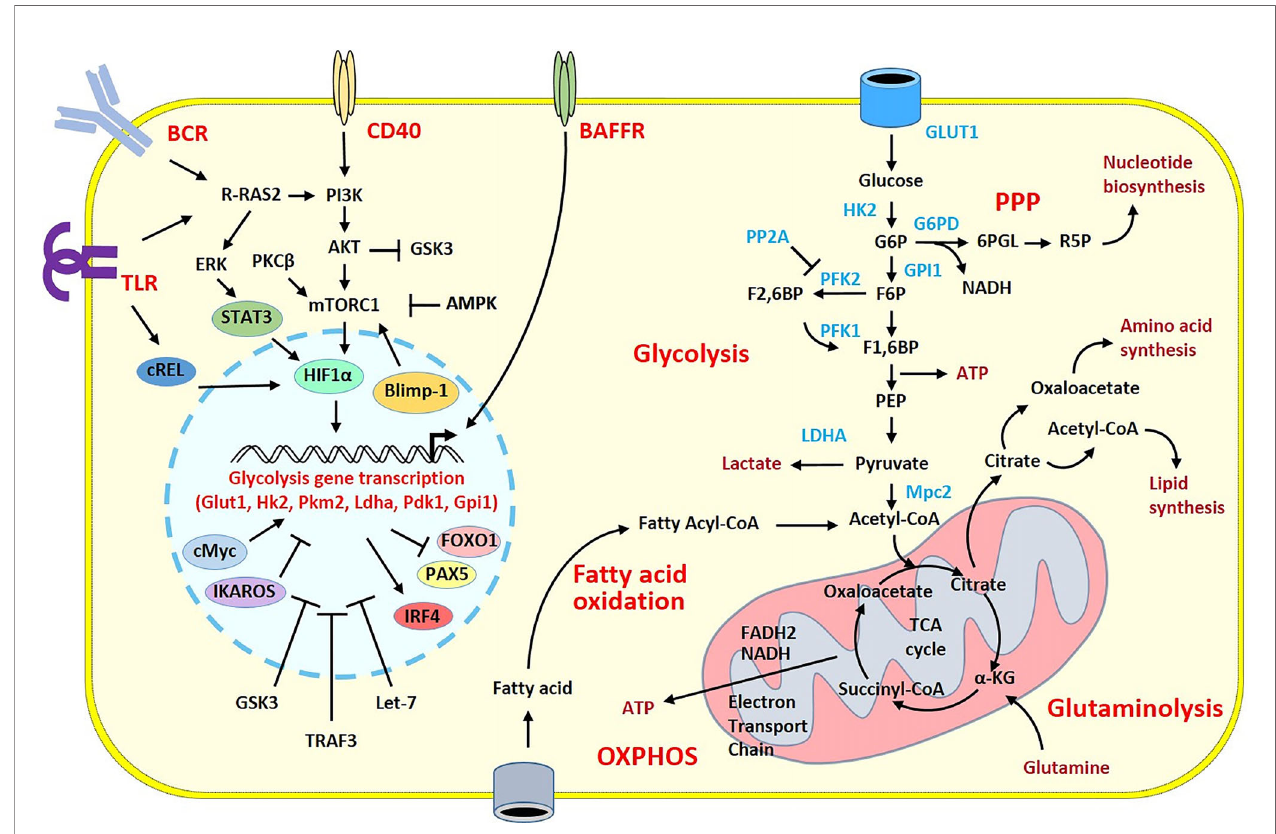
FIGURE 1 | Overview of the metabolic pathways and stimulatory signals in activated B cells. Glucose has a pivotal role in the supply of energy and biomolecules. GLUT1 regulates glucose transport allowing glucose to fuel the glycolytic pathway and the TCA cycle within the mitochondria. The TCA cycle produces NADH and FADH2, which deliver electrons fl ux to the Electron Transport Chain for ATP generation during the oxidative phosphorylation. B cell metabolism can shunt from these pathways toward the pentose phosphate pathway (PPP) to increase nucleotide biosynthesis. In activated B cells, the high fl ux of glucose grants the biomolecules required for the cell expansion. Because of that, there is a large production of lactate and increased lipid synthesis. Fatty acid oxidation and glutaminolysis reactions are also increased to sustain the TCA cycle and replace the intermediates consumed in other biological processes. Stimulatory signals from the BCR and TLRs or from CD40 or BAFFR co-stimulatory molecules activate intra-cellular pathways with the recruitment of transcription factors leading to the transcription of glycolysis genes in the nucleus. The induction of the metabolic programs is under the control of numerous transcription factors, miRNA and enzymes that have positive (pointed arrow) or inhibitory ( fl attened arrow) effects. Only intermediates, transcription factors, enzymes and signaling molecules mentioned in the review are shown. a -KG, a -ketoglutarate; AMPK, AMP-activated protein kinase; ATP, adenosine triphosphate; BCR, B cell receptor; F1,6BP, Fructose 1,6-bisphosphate; F2,6BP, Fructose 2,6-bisphosphate; F6P, Fructose 6-phosphate; G6P, Glucose 6-phosphate; G6PD, Glucose-6-phosphate dehydrogenase; GPI1, glucose-6-phosphate isomerase; 6PGL, 6-Phosphogluconolactonase; GSK3, glycogen synthase kinase 3; HK2, Hexokinase 2; LDHA, lactate dehydrogenase A chain; OXPHOS, Oxidative phosphorylation; PEP, Phosphoenolpyruvate; PFK1, Phosphofructokinase 1; PFK2, Phosphofructokinase 2; PP2A, Protein phosphatase 2; TLR,